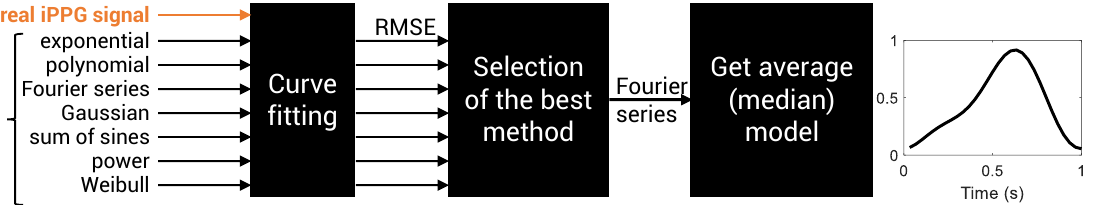
Figure 3. Fitting real iPPG signals to determine the best pulse wave model. Different models are tested. Fourier series were chosen because they present the lowest root mean square error (RMSE, see Figure 4 for details). They also have the advantage of fitting periodic signals.